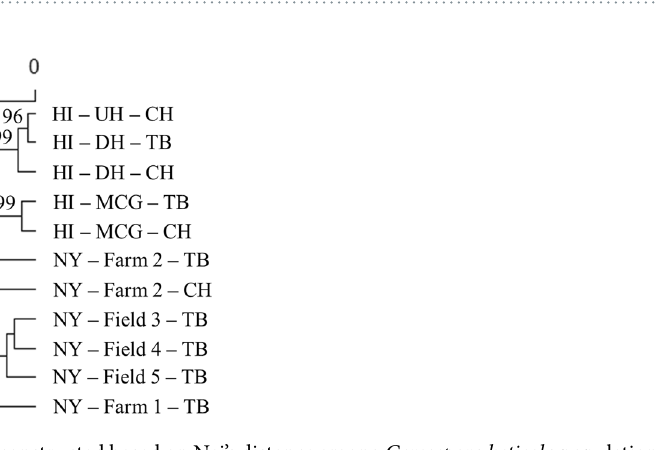
Figure 2. UPGMA dendrogram constructed based on Nei’s distance among Cercospora beticola populations from New York and Hawaii (MCG = Manoa community garden, UH = University of Hawaii organic garden, and DH = Diamond Head community garden), 2015, represented by state–field–host (TB = table beet and CH = Swiss